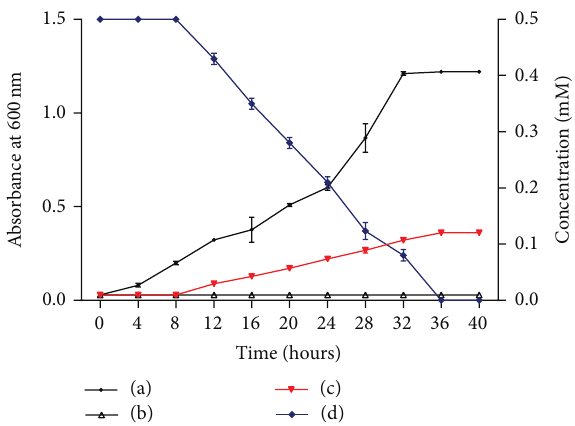
Figure 1: Growth of Arthrobacter sp. SPG in (a) minimal medium containing 10mM sodium succinate, (b) minimal medium con- taining 0.5 mM indole, and (c) minimal medium containing both 10 mM sodium succinate and 0.5 mM indole. (d) Indole depletion by Arthrobacter sp. SPG.